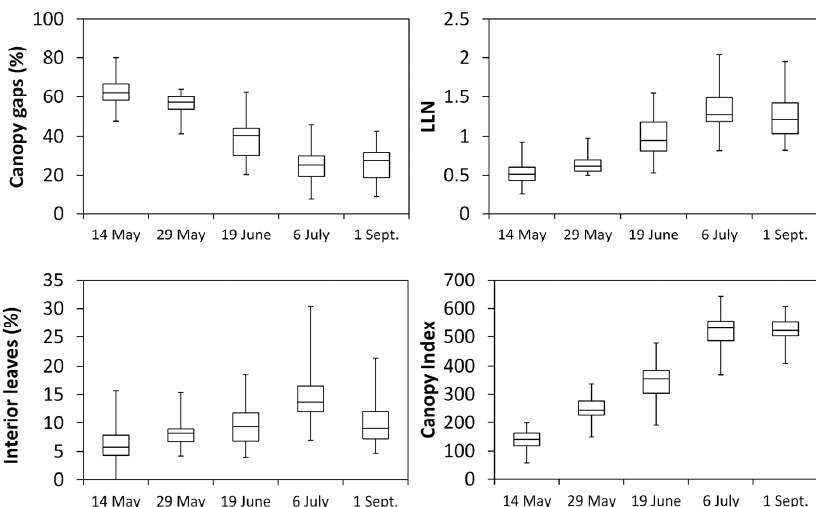
Figure 5. Box and whisker plots representation of fraction of canopy gaps, leaf layer number ( LLN ), fraction of interior leaves and Canopy Index ( CI ) for the five measuring dates. The bottom and top of each box are always the first and third quartiles, and the band inside the box is always the median. The ends of the whiskers represent the minimum and maximum of all of the data.